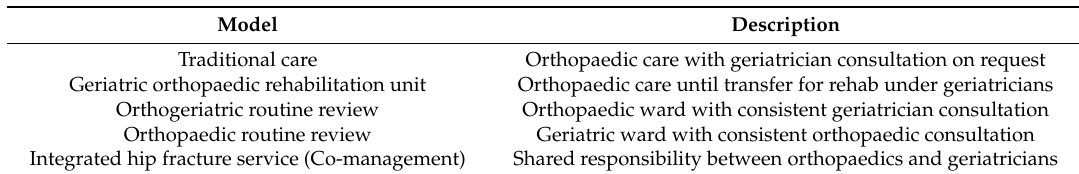
Table 1. Hip fracture care